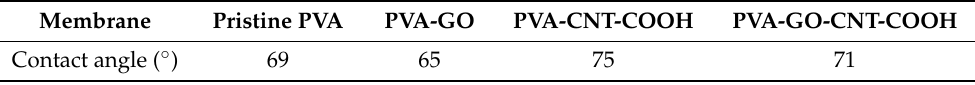
Table 2. Summary of Contact Angles for Pristine PVA and fabricated